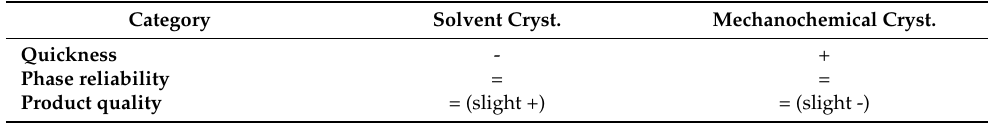
Table 4. Comparison of the solvent and mechanochemical crystallization regarding quickness, reliability of the received phase, and quality of the product in terms of further processing capabilities. A “+” symbol suggests a better result, a “-“ symbol a worse result and a “=” symbol an equal result. Category Solvent Cryst. Mechanochemical Cryst. Quickness - + Phase reliability = = Product quality = (slight +) = (slight